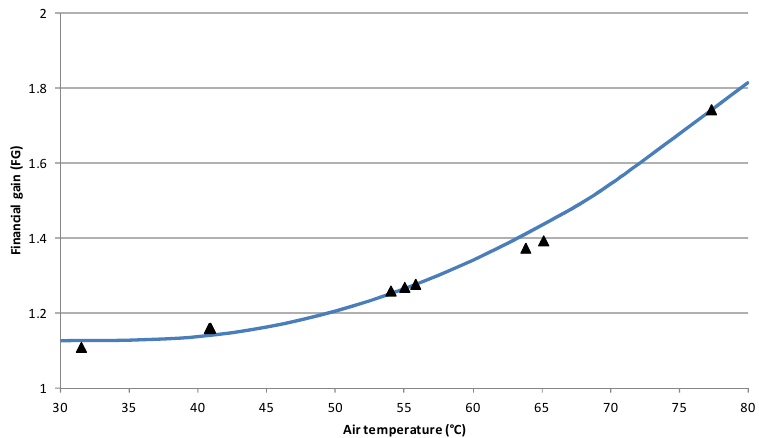
Figure 12. Financial gain as a function of the air temperature (DOE equation (line) and experimental tests (points)).